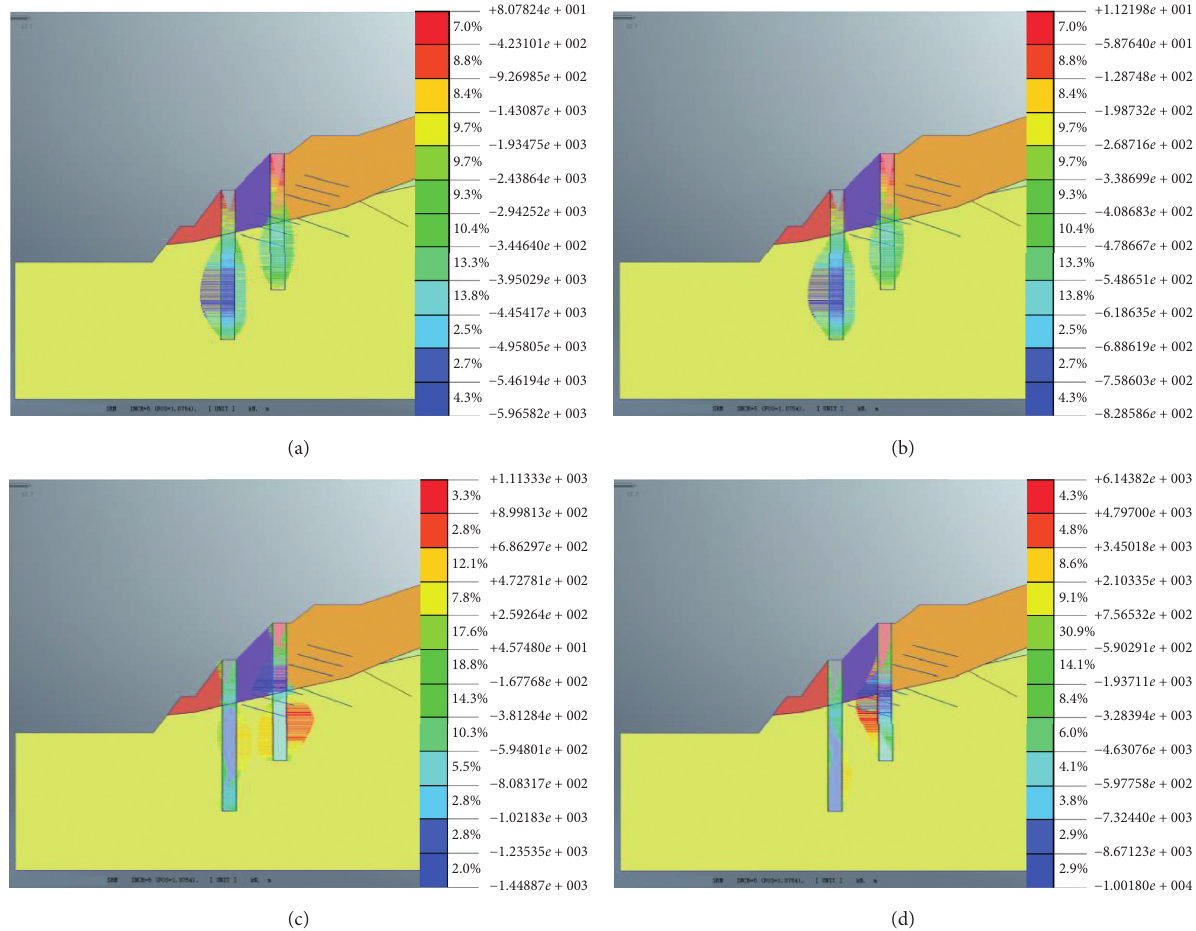
Figure 13: Cloud diagrams of the antislide piles without considering steady-state seepage: (a) axial force; (b) axial stress; (c) shear force; (d) bending